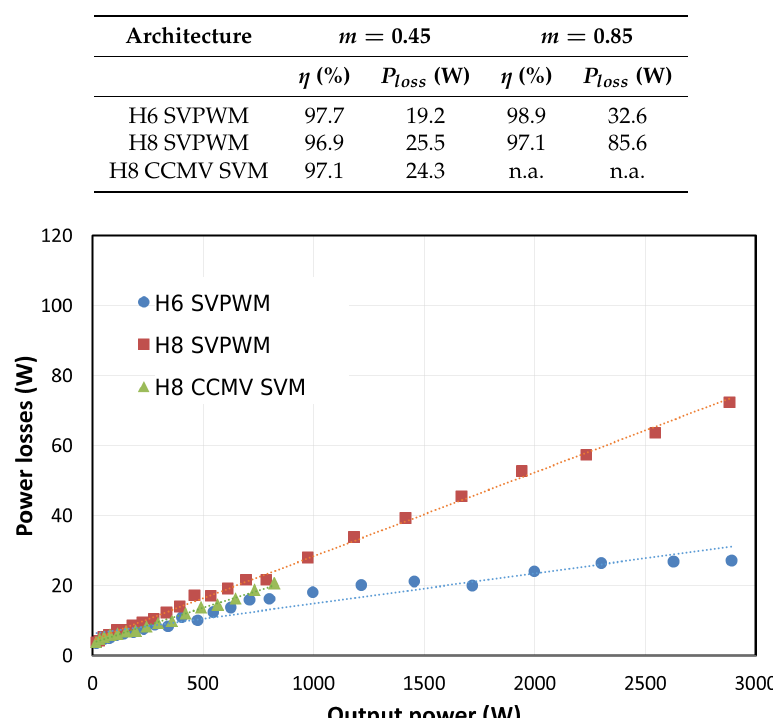
Table 6. Efficiency and total power loss comparison among H6 SVPWM, H8 SVPWM and H8 CCMV SVM. SiC power MOSFETs switching devices [17].